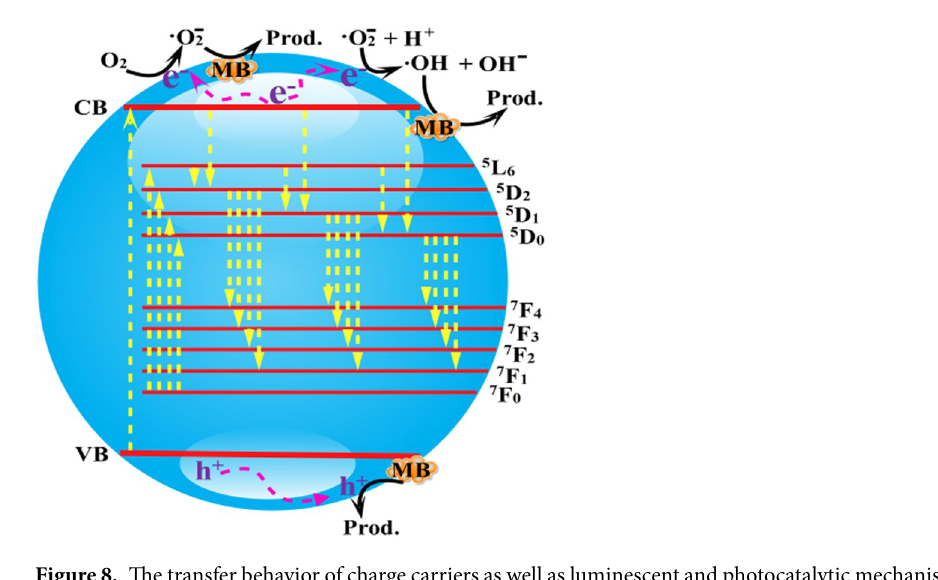
Figure 8. The transfer behavior of charge carriers as well as luminescent and photocatalytic